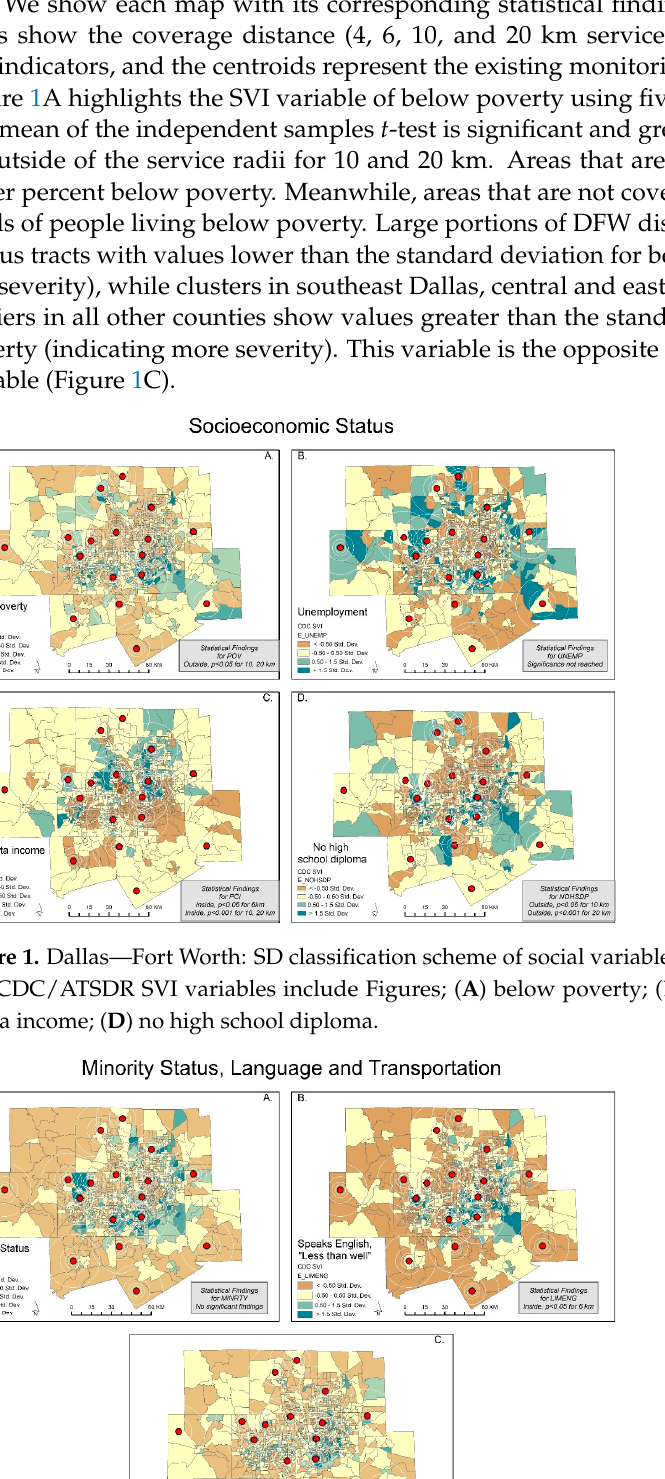
Figure 3. Dallas—Fort Worth: SD classification scheme of social variables for household composition and disability. The CDC/ATSDR SVI variables include Figures; ( AH ) aged 65 or older; ( BI ) age 17 or younger; ( CJ ) older than 5 with a disability; ( DK ) single parent households.